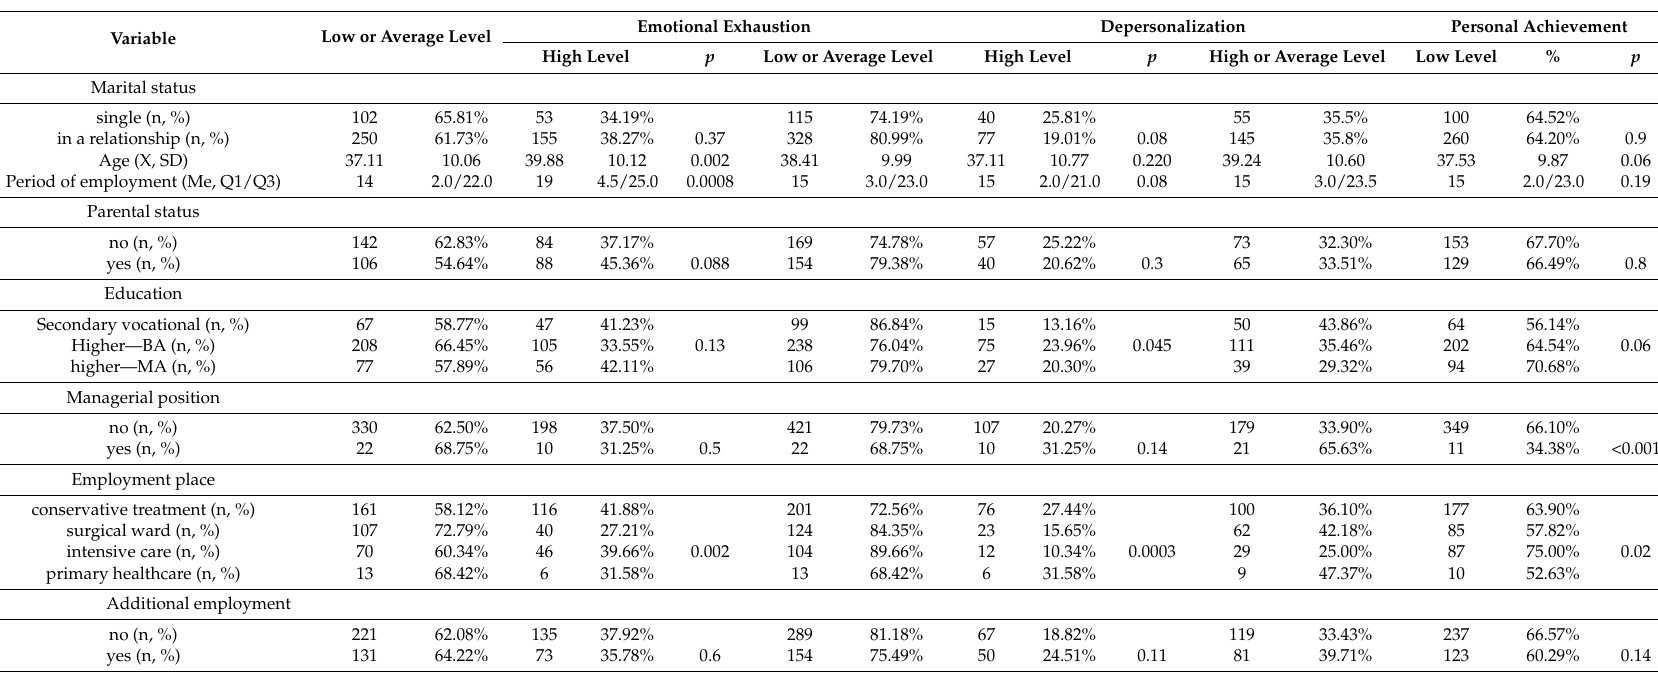
Table 4. Relation between selected socio-demographic factors and work characteristics and the level of emotional exhaustion, depersonalization, and personal